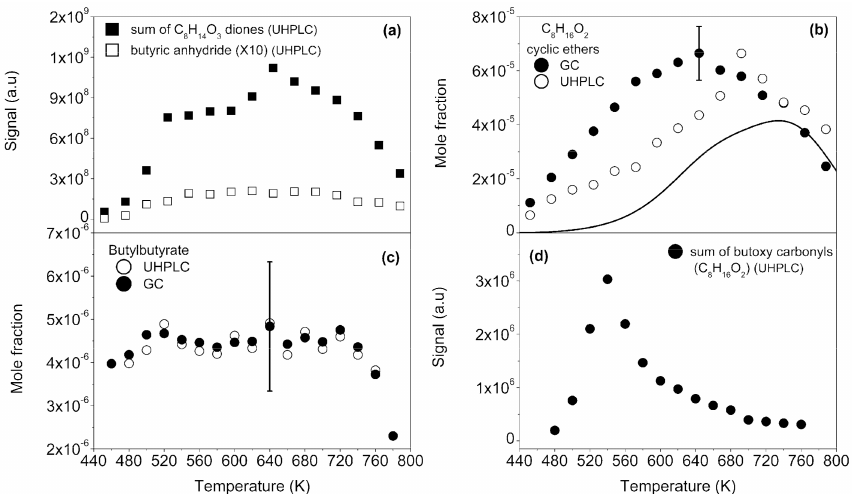
Figure 4. Comparison between mole fractions/signal profiles of diones (C 8 H 14 O 3 ), cyclic ethers (C 8 H 16 O 2 ), and other C 8 H 16 O 2 isomers formed during the low-temperature oxidation of di-n-butyl ether. ( a ): Comparison between UHPLC-HRMS experimental results for butyric anhydride and the sum of diones signal. ( b ): Comparison between experimental GC and UHPLC-HRMS data for cyclic ethers (C 8 H 16 O 2 ) and simulations (line). ( c ): Comparison between GC and UHPLC-HRMS experimental mole fractions of butyl butyrate (C 8 H 16 O 2 ). ( d ) UHPLC-HRMS-positive APCI signal profile of R’ (-H) =O species corresponding to C 8 H 16 O 2 butoxy-carbonyl